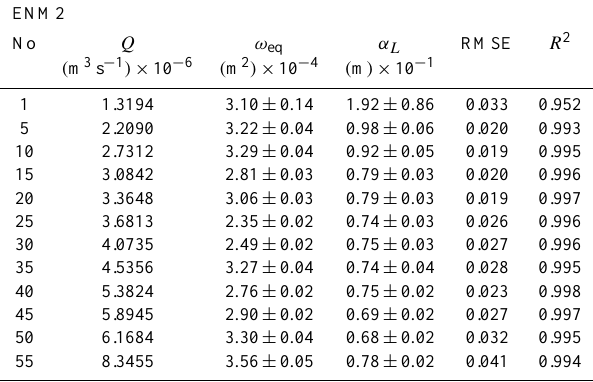
Table 2. Estimated values of parameters, RMSE, and determina- tion coefficient r 2 for ENM2 at different injection flow rates in the fractured